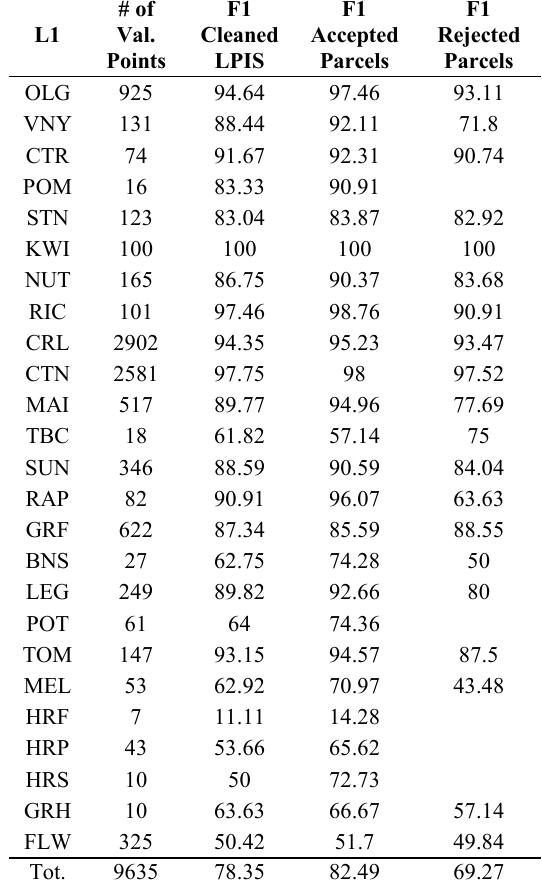
Table 5. F1 rates for the cleaned, the accepted and the rejected parcels per L1 class aggregated for the entire country, along with the respective number of validation points per